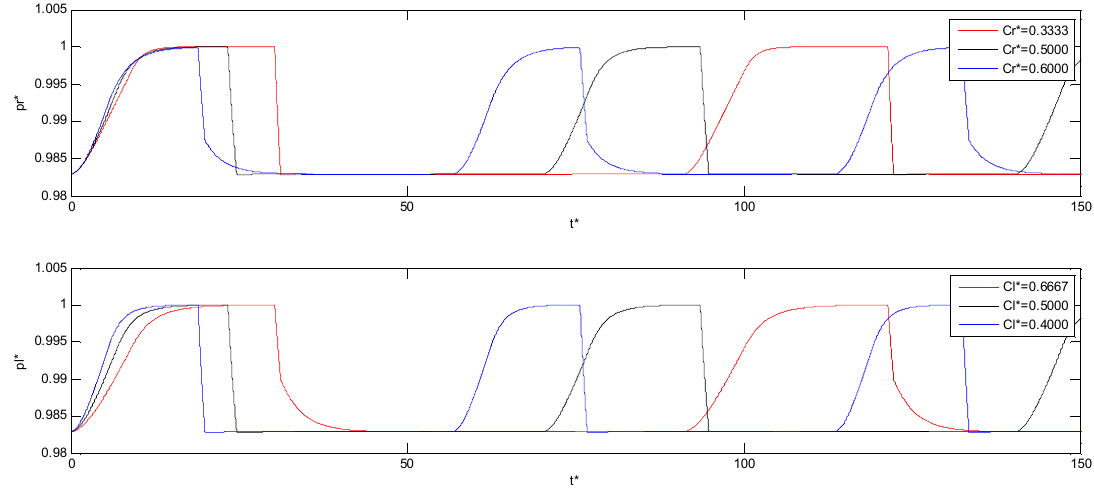
Figure 7. Influence of dimensionless compliance on dimensionless pressure of two lungs.